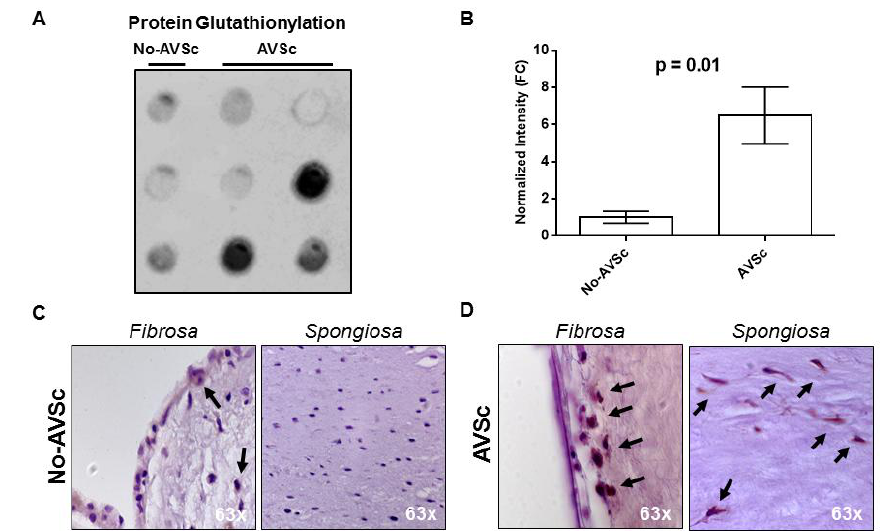
Figure 2. Aortic valve protein S-glutathionylation. ( A , B ) Dot-blot evaluation of total glutathione (GSH) expression in aortic valve leaflets (controls n = 3; AVSc n = 6) and relative quantification showed in the bar graph (dot-blot analyses using ImageJ; plugin: Dot-blot Analyzer v1.0). ( C , D ) Representative images showing histological analysis of human aortic valve in Fibrosa and Spongiosa layers. No-AVSc: patients with a normal aortic valve leaflet. AVSc: patients with aortic valve sclerosis. Black arrows indicate positive cells for GSH